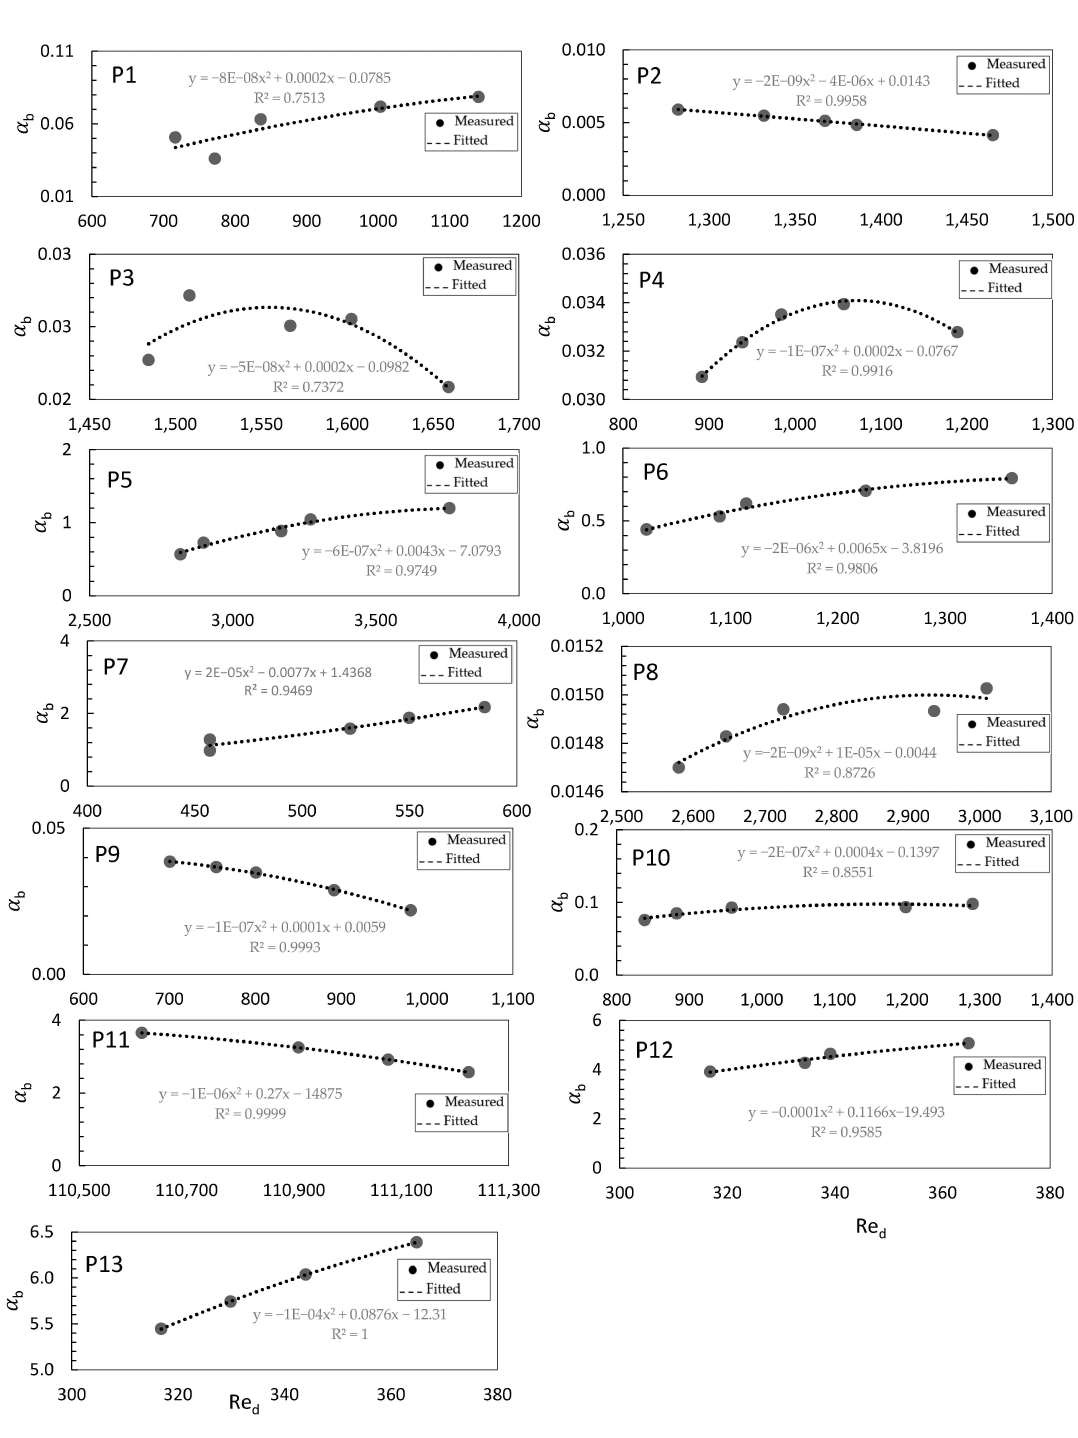
Figure 11. Variations in the drag coefficient factor α b with Re d